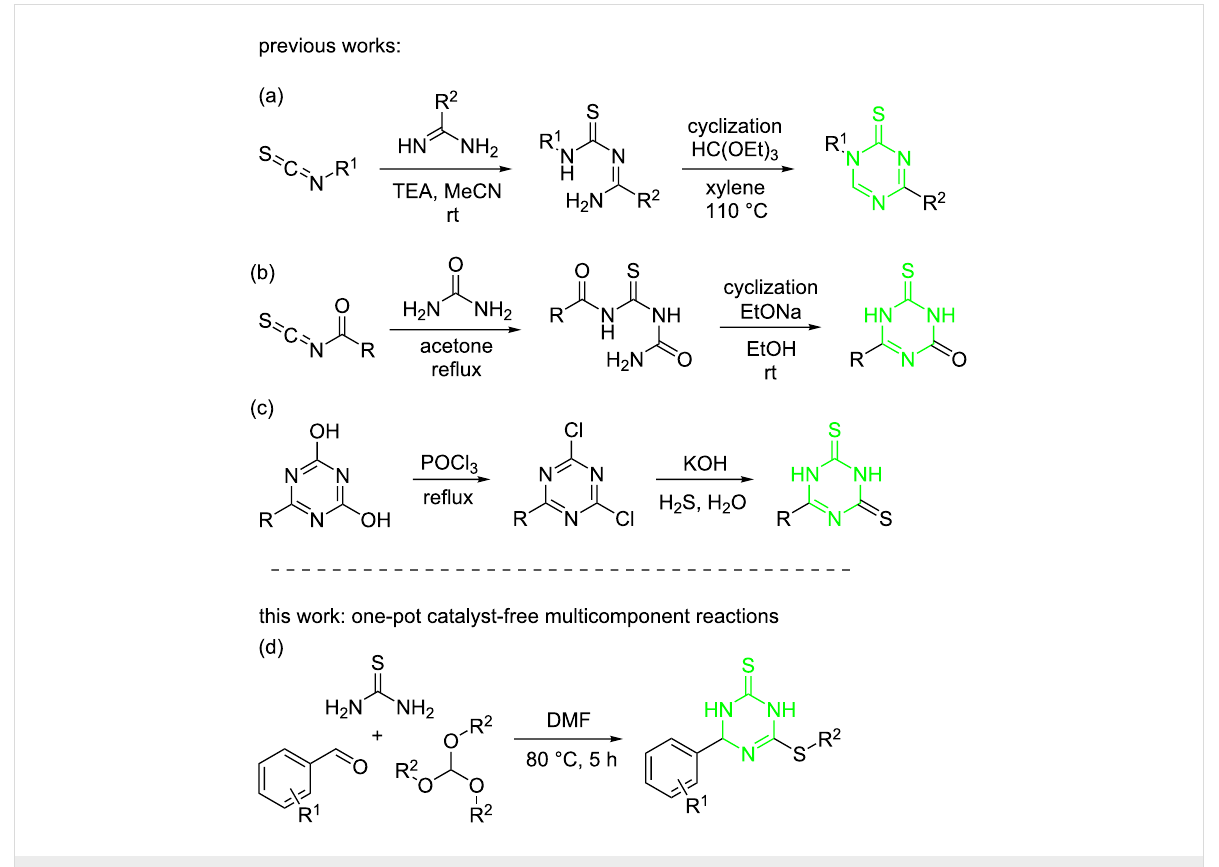
Scheme 1: Strategies for the synthesis of